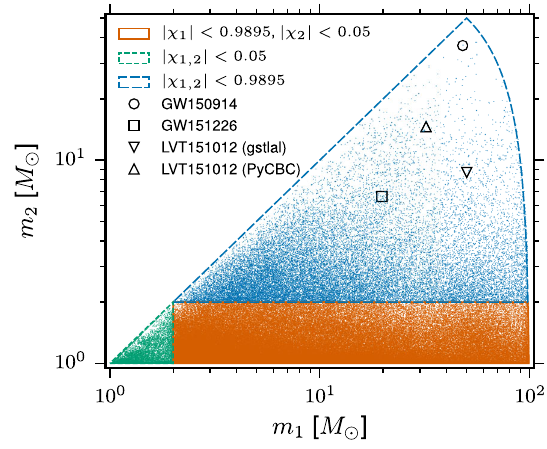
FIG. 2. The four-dimensional search parameter space covered by the template bank shown projected into the component-mass plane, using the convention m 1 > m 2 . The colors indicate mass regions with different limits on the dimensionless spin parameters χ χ 1 and 2 . Symbols indicate the best matching templates for GW150914, GW151226, and LVT151012. For GW150914 and GW151226, the templates were the same in the PyCBC and GstLAL searches, while for LVT151012 they differed. The parameters of the best matching templates are consistent, up to the discreteness of the template bank, with the detector frame mass ranges provided by detailed parameter estimation in Sec.